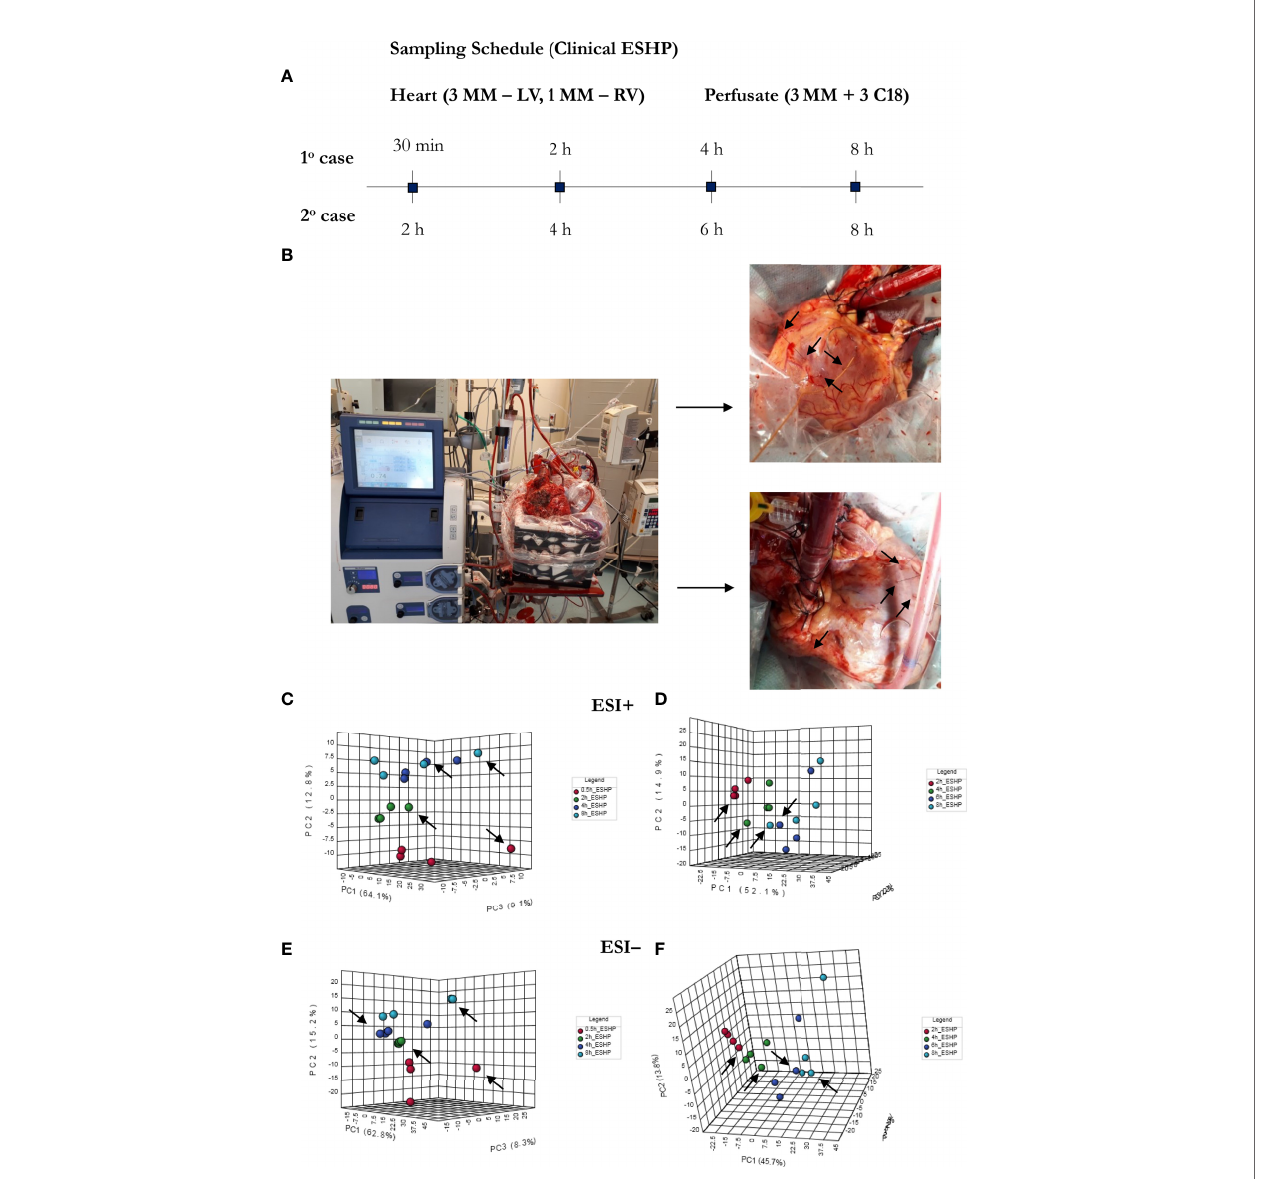
FIGURE 6 | Bio-SPME sampling of human hearts during ESHP. (A) Time schedule of heart and perfusate sampling. (B) Three Bio-SPME probes inserted into the LV (left ventricle) to a depth of 8 mm (full coating length), and one microprobe inserted into the RV (right ventricle). (C – F) PCA (principal component analysis) score plots for metabolites detected in human heart samples collected ex vivo via SPME. Relevant plots were generated for metabolic features detected in ESI+ (C, D) and ESI- (E, F) /PFP-based mode. The different groups of samples (associated with duration of perfusion) are distinguished using different colors. For clinical case 1: red — samples taken at 30 min of ESHP; green — samples taken at 2 h of ESHP; dark blue — samples taken at 4 h of ESHP; light blue — samples taken at 8 h of ESHP. For clinical case 2: red — samples taken at 2 h of ESHP; green — samples taken at 4 h of ESHP; dark blue — samples taken at 6 h of ESHP; light blue — samples taken at 8 h of ESHP. The arrows depict samples collected from the